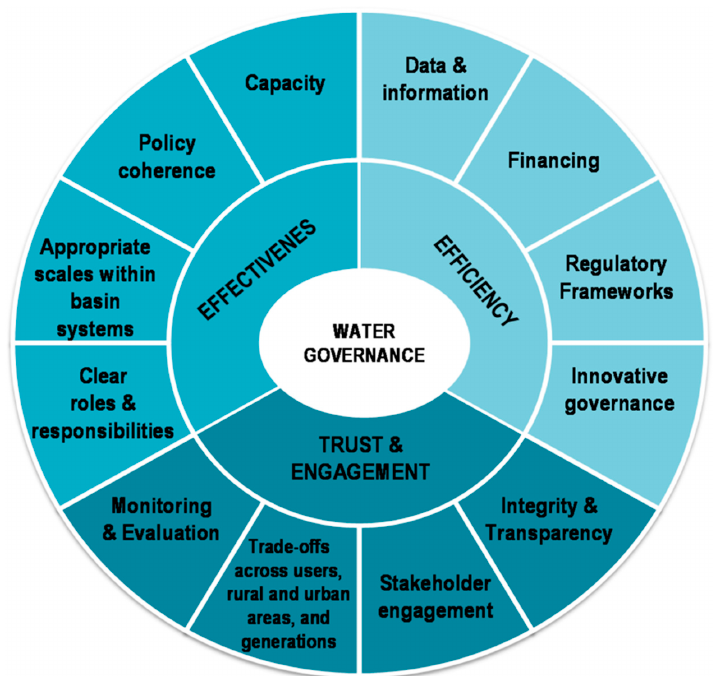
Figure 1. The OECD Principles on Water Governance, adapted from OECD (2015) [13].